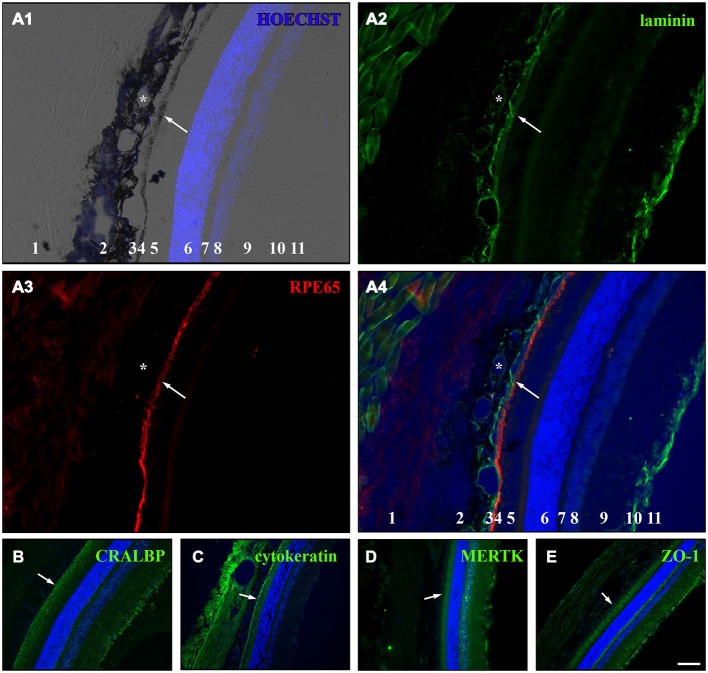
Immunostaining for RPE cell markers in whole eye cross sections. Ten week old LH rats were perfused with 4% PFA before the eyes were cryosectioned (14 μm). Afterwards, immunostaining was used to visualize several RPE cell markers in the eye sections (Table 2). HOECHST was used to illuminate cell nuclei (blue). (A) Staining for laminin (green) and RPE65 (red) in cryosections of LH rat. Numbers in A1 and A4: 1 = sclera, 2 = choroid, 3 = Bruch’s membrane, 4 = RPE, 5 = photoreceptor outer segments (POS), 6 = outer nuclear layer (ONL), 7 = outer plexiform layer (OPL), 8 = inner nuclear layer (INL), 9 = inner plexiform layer (IPL), 10 = retinal ganglion cell (RGC) layer, 11 = inner limiting membrane (ILM). (A1) Merge picture of brightfield and HOECHST (blue). The pigmented choroid (2) and RPE cell layer (4) are clearly evident in the brightfield image. The lumina of the blood vessels (asterisk) are visible in the choroid (2). The HOECHST staining visualizes the ONL (6) and the INL (8) with some faint cells visible in the RGC layer (10). (A2) Immunostaining for laminin (green) highlights the blood vessels (asterisk) within the choroid (2), the Bruch’s membrane (3) and the ILM (11). Also connective tissue outside the eye is stained for laminin. (A3) The monolayer of RPE cells (4) is strongly visible in addition to faint background staining in the sclera (1) and the region of the POS (4) when the cryosections were stained for RPE65 (red). (A4) In the merge image of the HOECHST (blue), laminin (green) and RPE65 (red) staining, it becomes clear that the Bruch’s membrane is immunopositive for laminin and is located adjacent to the RPE cell layer which is sandwiched between the choroid and the POS. (B) RPE as well as Müller cells expressed cellular retinaldehyde binding protein (CRALBP, green) which was especially visible in the Müller end feet that are part of the ILM. (C) Immunostaining for cytokeratin 18 (green) illuminated the RPE cells and also led to staining in the sclera and choroid. (D) The c-mer proto-oncogene tyrosine kinase (MERTK, green) was expressed by RPE cells and cells in or adjacent to the INL and the ILM. (E) The tight junction marker zona occludens protein 1 (ZO-1, green) was expressed in the RPE cells and in cells in the ILM. The white arrows are pointing towards the RPE cell layer in (A–E). Scale bar = 100 μm.